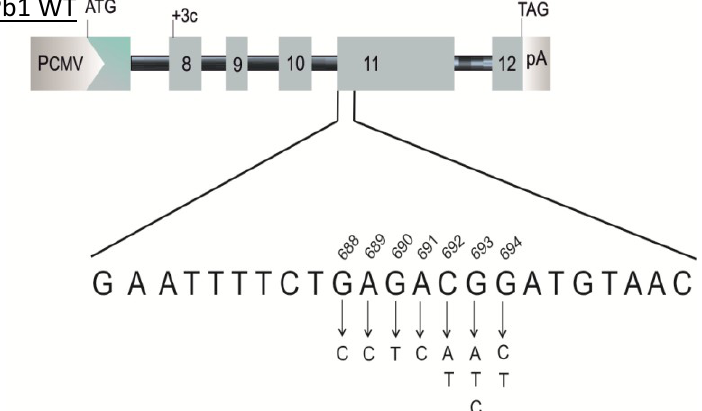
Figure 3. Site-directed representation. Schematic representation of the minigene pB1 WT and the single nucleotide change from nucleotide c.688 to c.694. PCMV, promoter cytomegalovirus; pA = poly A. Pb1 WT